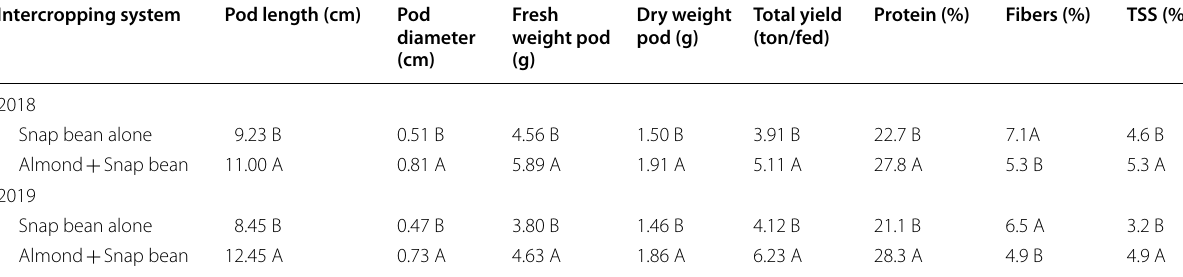
Table 4 Effect of intercropping on snap bean yield and pod quality Intercropping